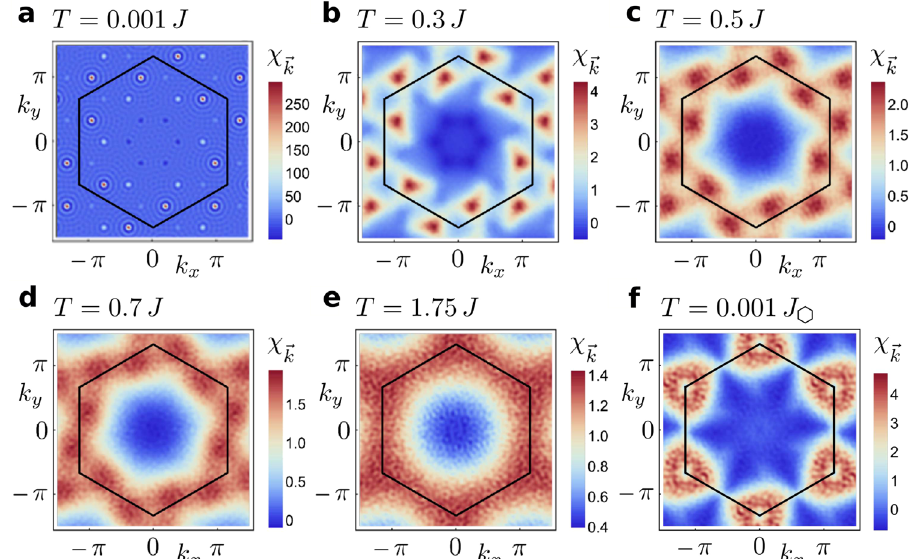
Fig. 5 Classical Monte Carlo results. a – e Spin susceptibility in momentum space at different temperatures from classical Monte Carlo simulations for the S XRD structure on a cluster with N = 7803 spins (type-II cluster with L = 17, see Supplementary Note 1), with γ = 0.001 (see Methods for details). We only consider fi nite real-space correlations within a circle with a radius of 50 nearest-neighbor distances around each spin. The extended Brillouin zone is depicted as a black hexagon, cf. Fig. 1b. f Spin susceptibility for J / J ⬡ = 0.5 and J 0 = J ⬡ ¼ 0 : 45 , within the non-coplanar phase. The susceptibility has been computed by classical Monte Carlo calculations for ten N = 7803 sites clusters (type-II, L = 17, see Supplementary Note 1) at T = 0.001 J ⬡ .